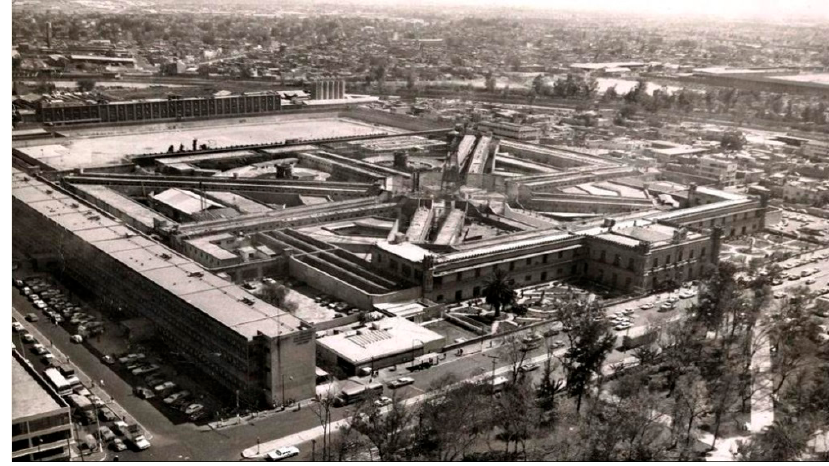
Figure 2. Aerial view of the old Lecumberri Prison (1970s) [10].